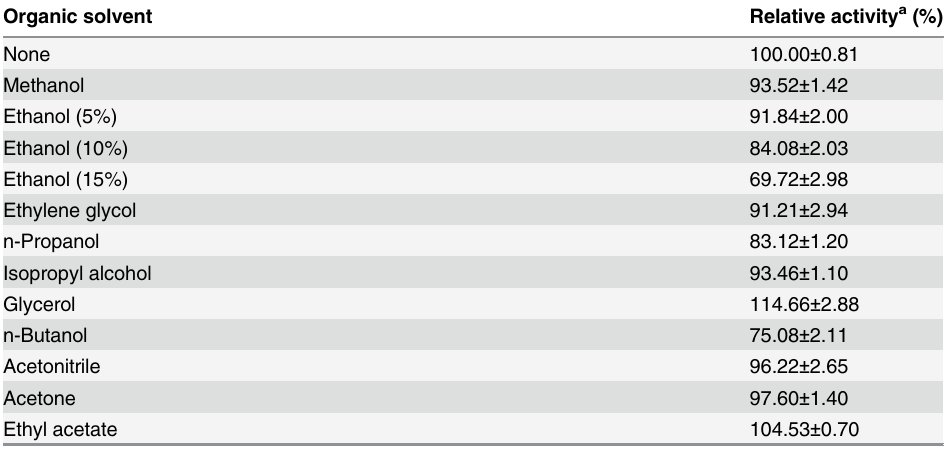
a Data are means ± standard deviation from three replicates. The experiments were repeated three